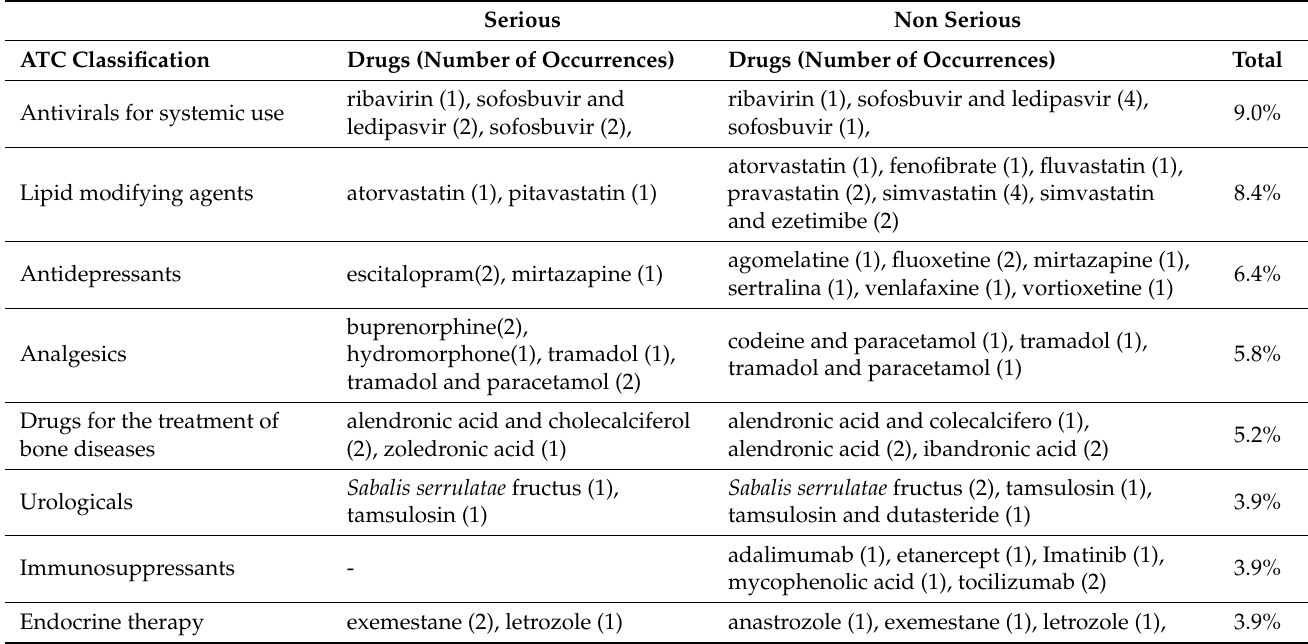
Table 2. Anatomical Therapeutic Chemical Classification System code (ATC): drugs most frequently involved in adverse drug reactions (ADRs) and the number of occurrences for each one.